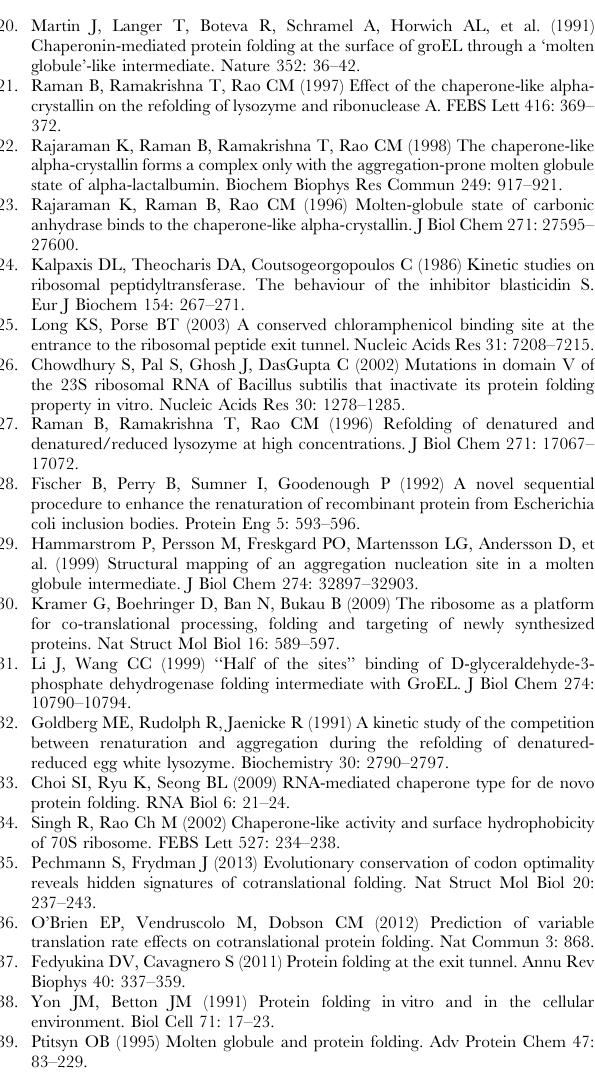
Figure S4 Binding and release of BCAII-m in the presence of wild type and mutant RNA. The time course of binding of BCAII-m with wild type bacterial RNA1 (- m -) and bDV RNA1 mutant U2585C (- & -) and wild type bacterial